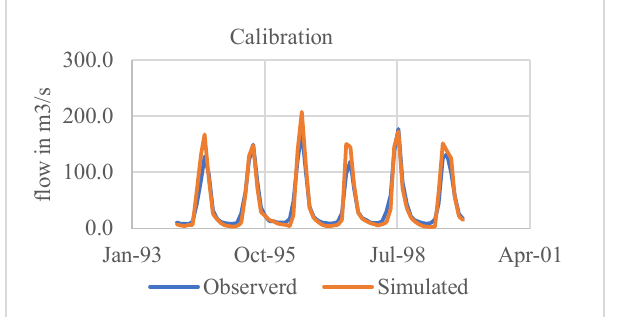
Figure 6. Comparison of Observed and Simulated monthly flow for validation period